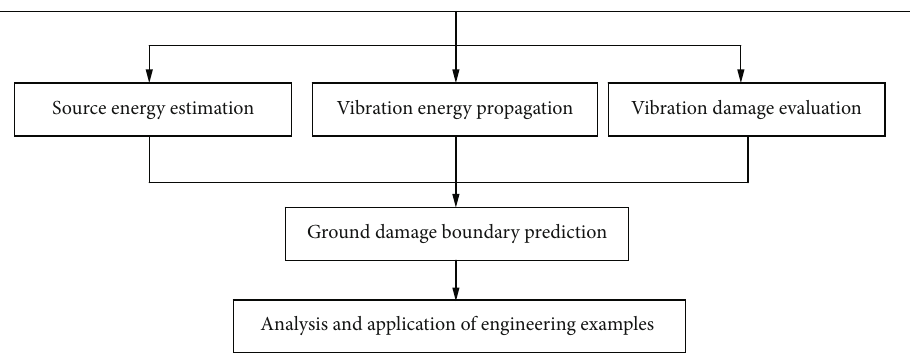
Figure 3: Main research contents and technical roadmap.